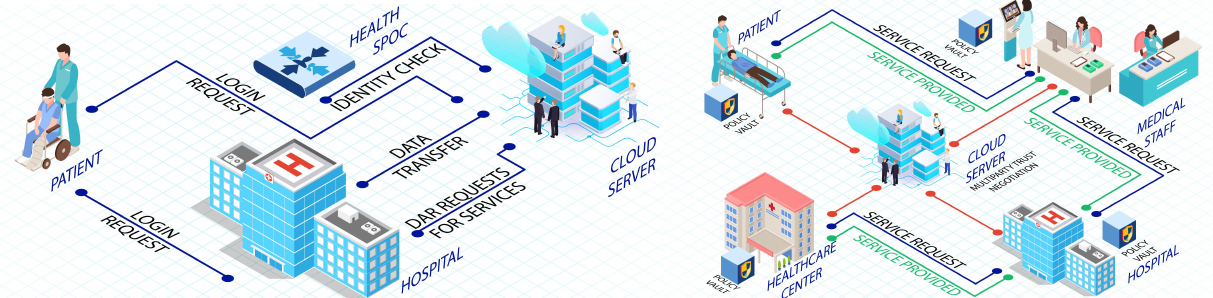
Figure 4. Privacy- and security-enhanced e-health framework [89] and SOTER: A trust discovery framework